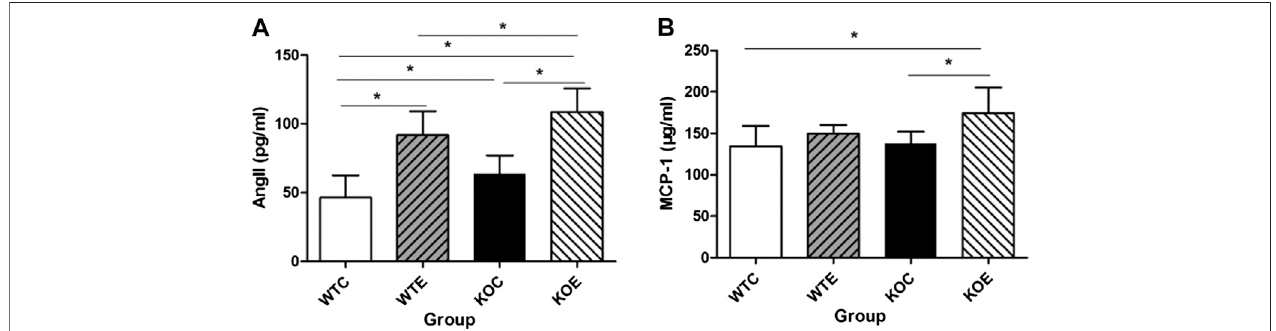
FIGURE 7 | ELISA Results of Ang II and MCP-1 6 – 8 weeks C57/B6 mice, with or without Nrf2 knockout were exposed to either fi ltered air or air containing particulatematter(PM)forsixweeks,andthenthebloodwassubjectedtoELISAassayforAngIIandMCP-1.*:statisticallydifferentbetweenthetwogroups( p < 0.05).N (cid:2) 10 per group. (A) : The serum concentration of Ang II. (B) : The serum concentration of